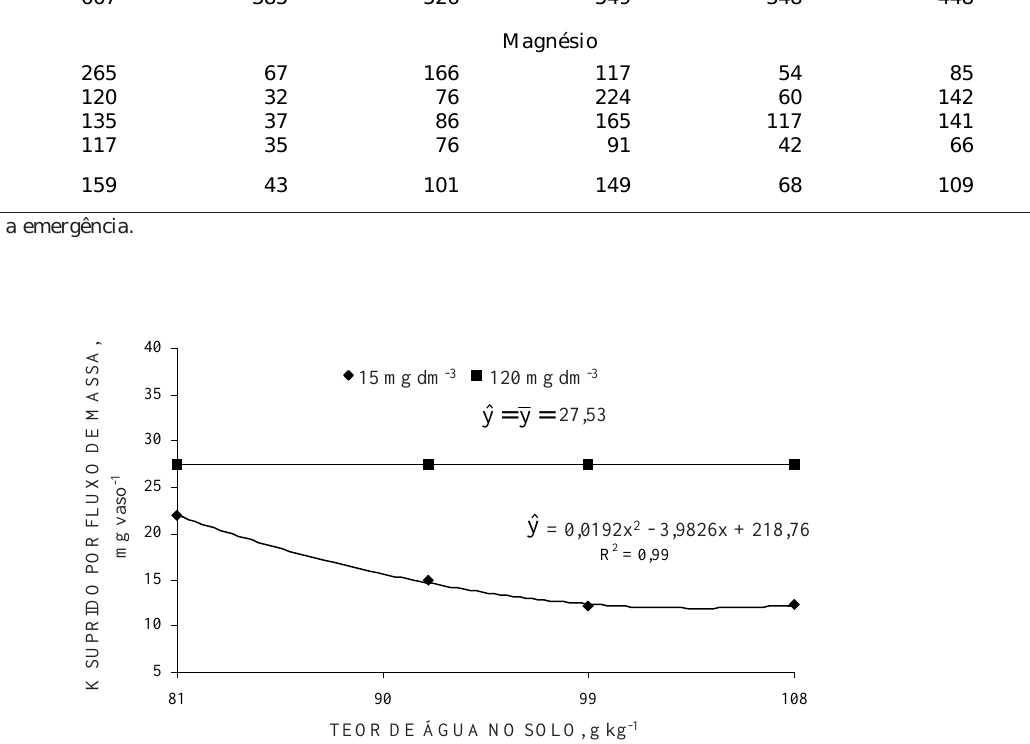
Figura 2. Quantidade de potássio suprida às raízes de milheto (28 DAE) por fluxo de massa, considerando os teores de água no solo, correspondentes aos potenciais testados, e as doses de potássio. Símbolos = valores observados; linha = valores